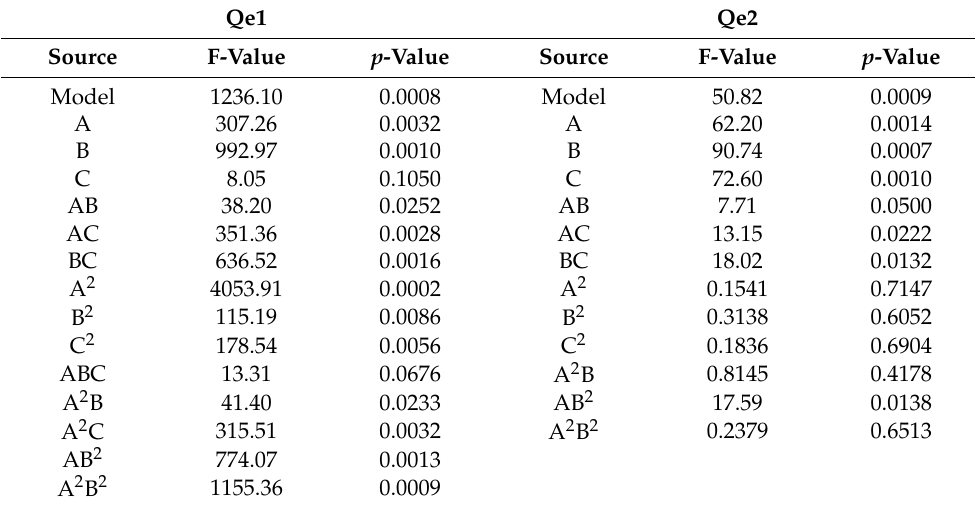
Table 4. ANOVA for CoAl-LDH and bentonite-CoAl-LDH RSM